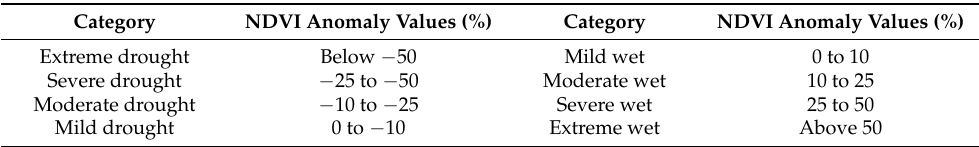
Table 1. Categorization of dryness/wetness of normalized difference vegetation index (NDVI) anomaly